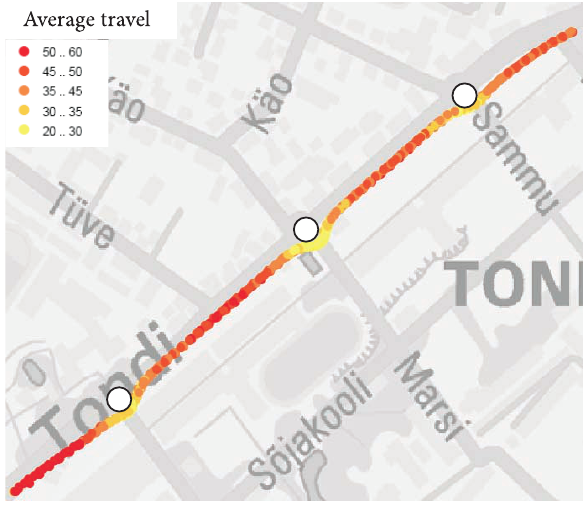
fig. 4. Average travel speeds at Tondi street (Tallinn), passing 3